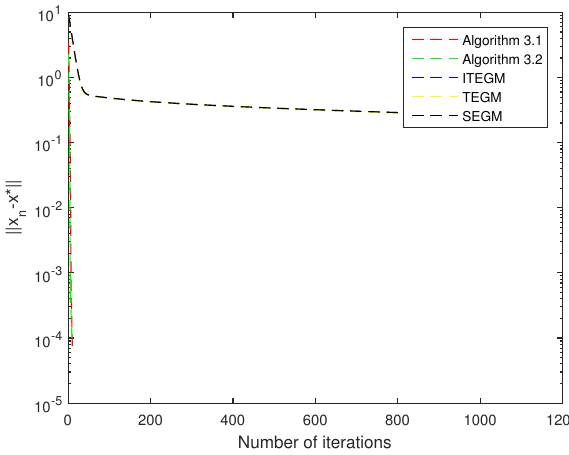
Figure 4. Comparison of all algorithms with m =